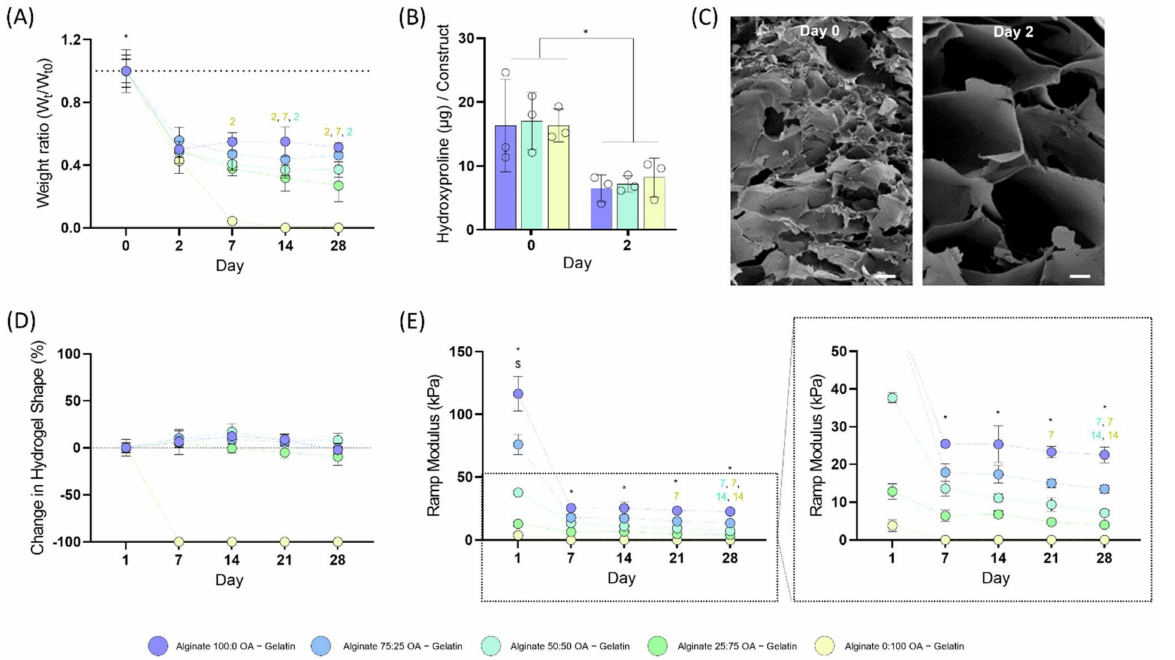
Figure 3. Hydrogel characterization. ( A ) Dry weight of 3D printed hydrogels at various time points. * different to all time points; 2,7 different to day 2 and day 7 (color equals condition). ( B ) Quantification of the hydroxyproline levels in each construct at day 0 and day 2. ( C ) SEM images at Day 0 and Day 2 revealing the increased porosity after the gelatin removal. The scale bars are equal to 20 µ m. ( D ) Hydrogel shape tracking as a function of time. ( E ) Mechanical properties of the different bioinks at different time points. * all groups are different; 7, 14 different to day 7 and day 14 (color equals condition). $ different to all time